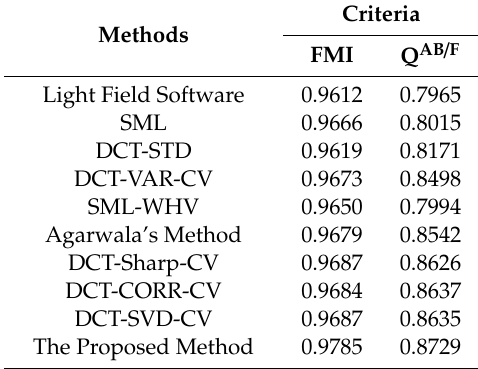
Figure 12. Comparison of ‘Bag’ image results: ( a ) Light Field Software, ( b ) SML, ( c ) DCT-STD, ( d ) DCT-VAR-CV, ( e ) SML-WHV, ( f ) Agarwala’s method, ( g ) DCT-Sharp-CV, ( h ) DCT-CORR-CV, ( i ) DCT-SVD-CV, ( j ) The Proposed Method. Table 1. Objective evaluation of the image results (non-reference fusion metrics) for ‘Bag’ image.